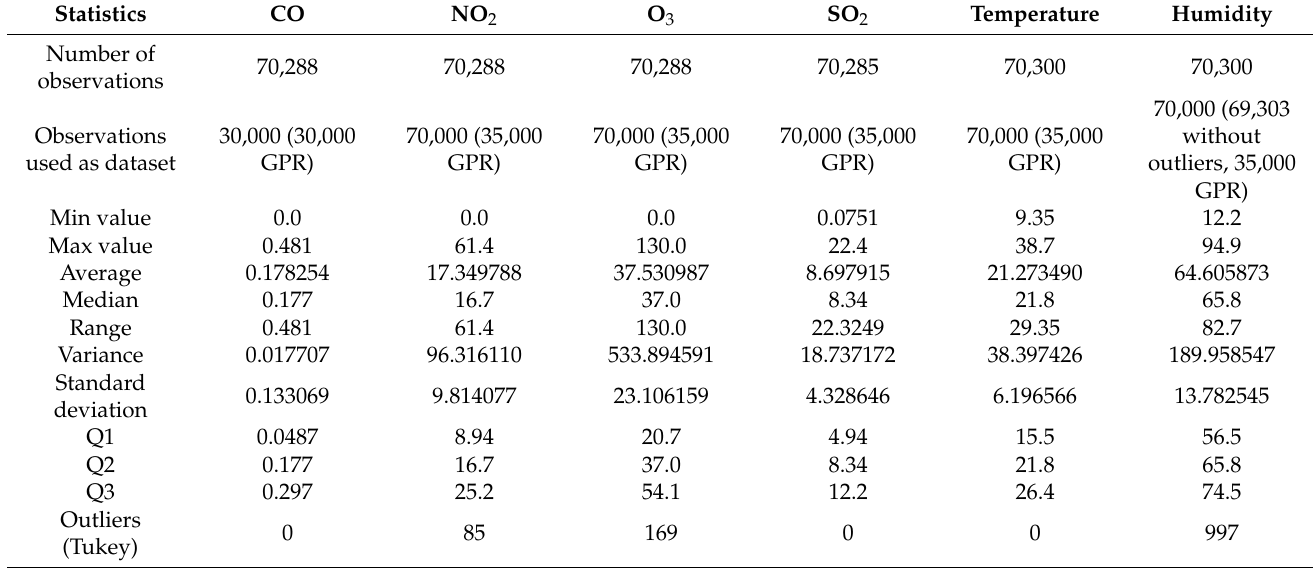
Table 3. Statistical details of the data for the polluting gas measuring device.